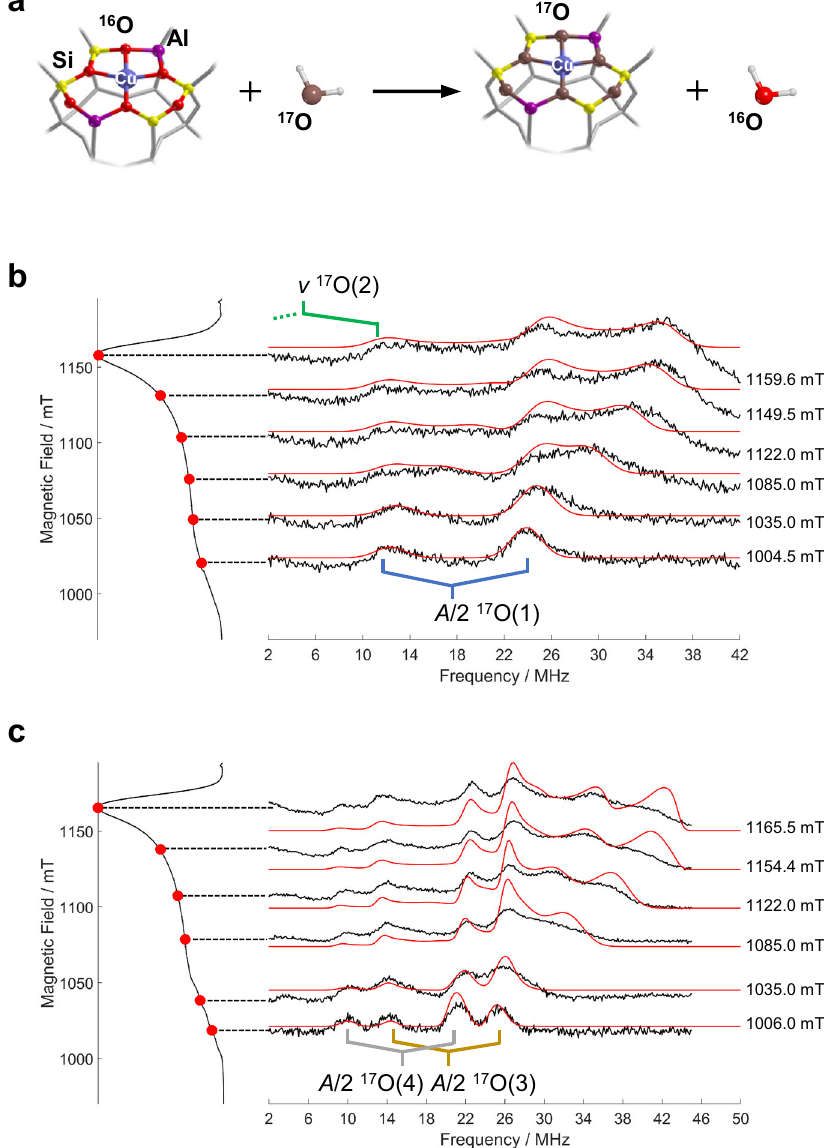
Fig. 3 17 O ENDOR spectra of isotopically enriched Cu-CHA. a Schematic representation of the isotopic enrichment of the zeolite framework. b Experimental (black) and simulated (red) Q-band 17 O ENDOR spectra recorded at different magnetic fi eld settings of 17 O isotopically enriched Cu-CHA fully hydrated with H 2 17 O. c Corresponding experiment performed on a fully dehydrated 17 O enriched Cu-CHA. The ESE spectra with the corresponding fi eld positions at which the ENDOR spectra were taken are plotted on the left-hand side. All spectra were recorded at 20